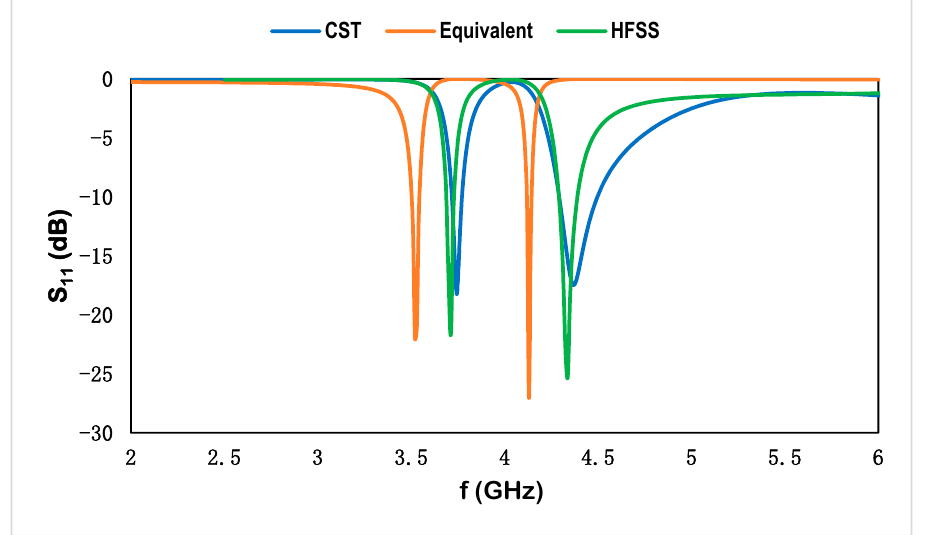
Figure 10. Reflection coefficient using different simulators for the proposed sensor.